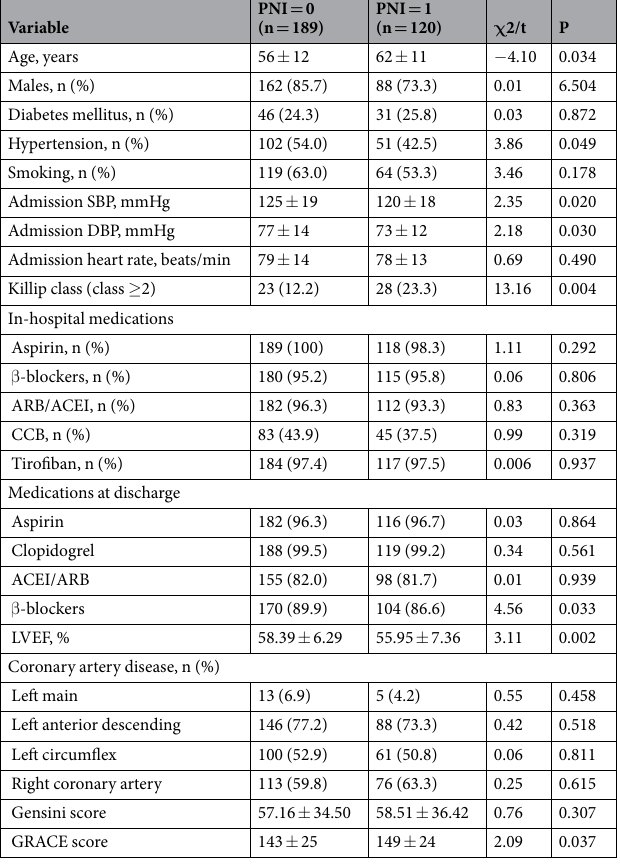
Table 1. Baseline clinical characteristics of patients with acute STEMI after pPCI by PNI score group. SBP, systolic blood pressure; DBP, diastolic blood pressure; ARB, angiotensin II receptor blocker; ACEI, angiotensin- converting enzyme inhibitor; CCB, calcium-channel blocker; GRACE, the Global Registry of Acute Coronary Events; IABP, intra-aortic balloon pump counterpulsation; LVEF, left ventricular ejection fraction; PNI, prognostic nutritional index; STEMI, acute ST-segment elevation myocardial